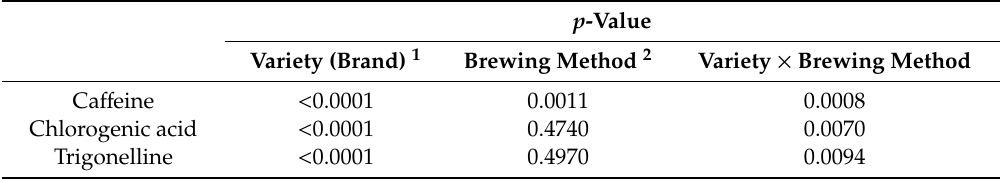
Table2. E ff ectsofco ff eevariety(brand)andbrewingmethodonthe p -valuesofca ff eine, chlorogenicacid, and trigonelline contents in cold brew (CB) and co ff ee maker (CM)